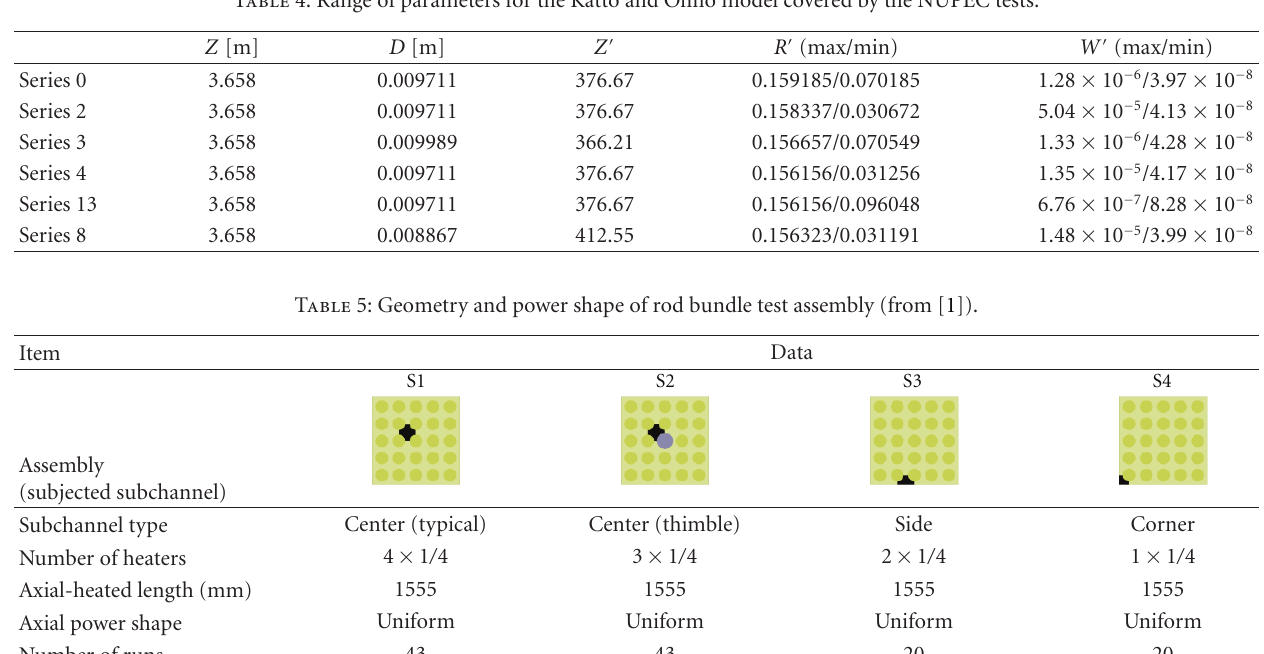
Table 4: Range of parameters for the Katto and Ohno model covered by the NUPEC tests.